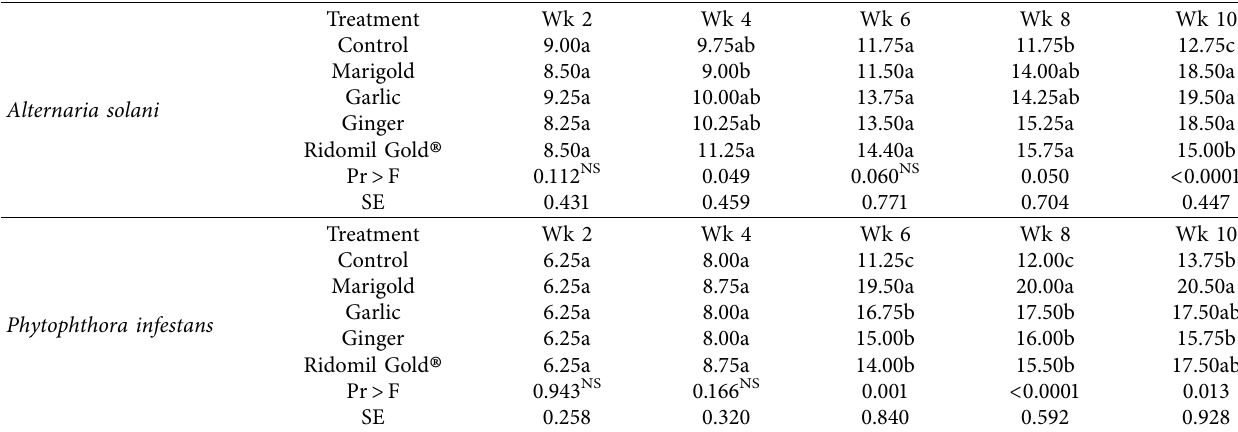
Table 3: Number of leaves on inoculated tomato